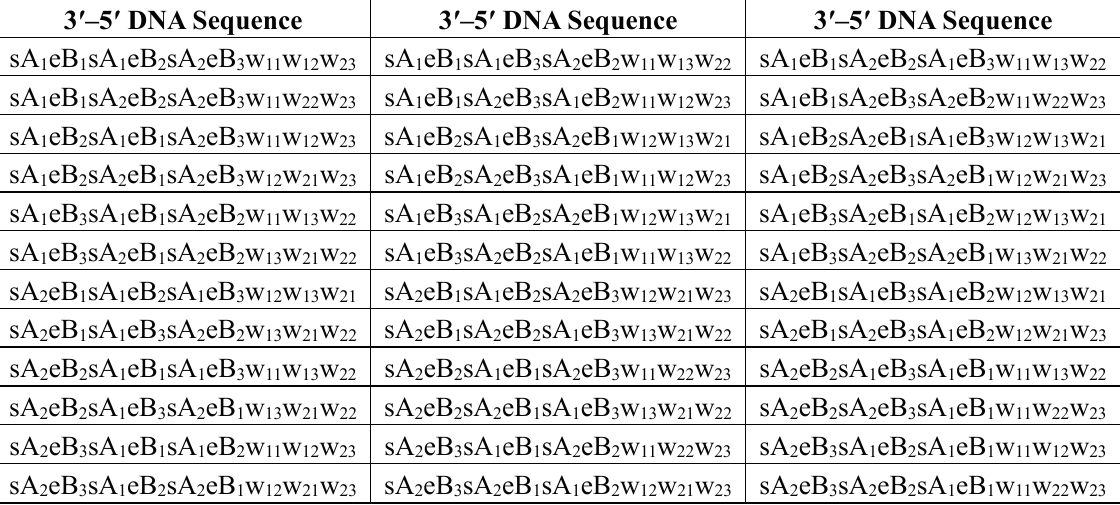
Table 6. DNA Sequences symbols after Step (4) for Table 2.